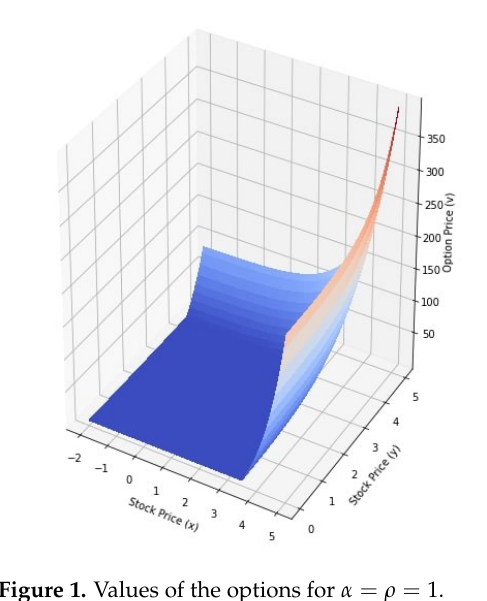
Figure 1. Values of the options for α = ρ = 1.